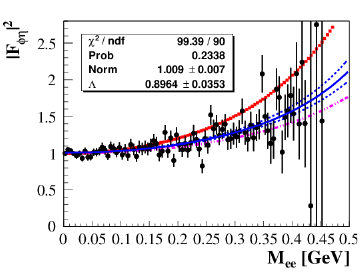
Figure 8: e + e − invariant mass of φ → η e + e −